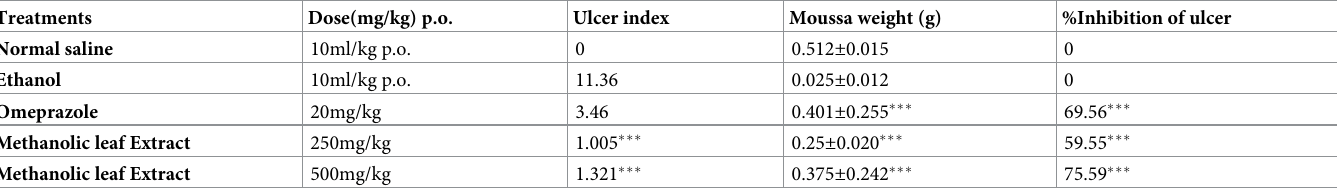
Table 8. Effect of different methanolic extracts of E . spinosa on ulcer index, mucosa weight, % inhibition in acute ethanol-induced gastric ulcer. Treatments Dose(mg/kg)